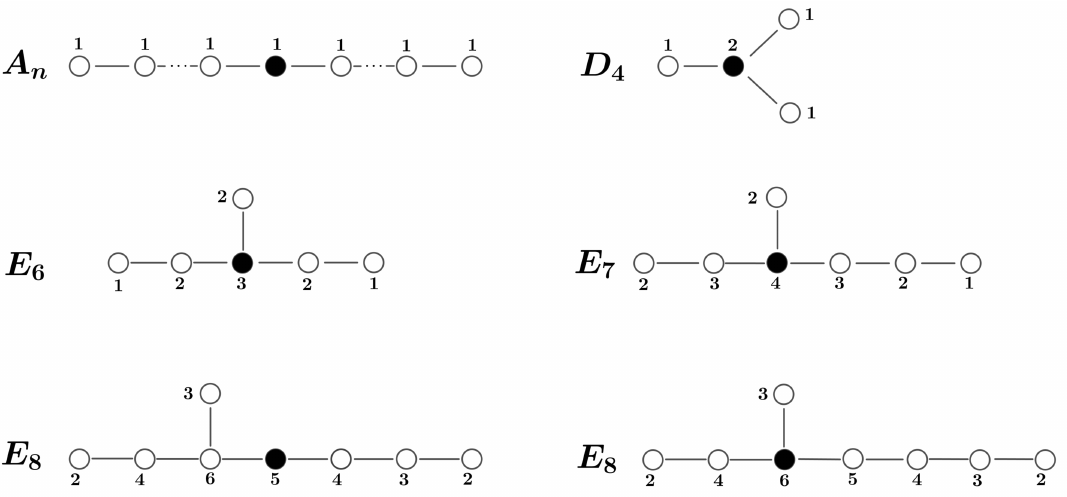
Figure 2 . ADE Dynkin diagrams and dual Coxeter labels of the